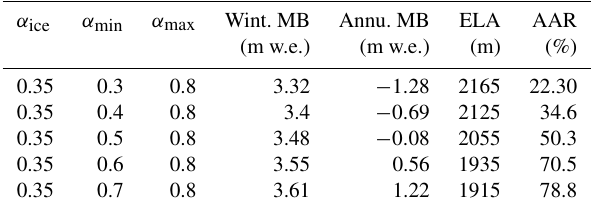
Table 2. Albedo values for ice ( α ice ), old snow (firn, ( α min )), and fresh snow ( α max ) used for the sensitivity study of Alerce glacier- wide mass balance to change in the albedo. The winter and annual glacier-wide surface mass balance (MB), ELA, and AAR for each simulation is